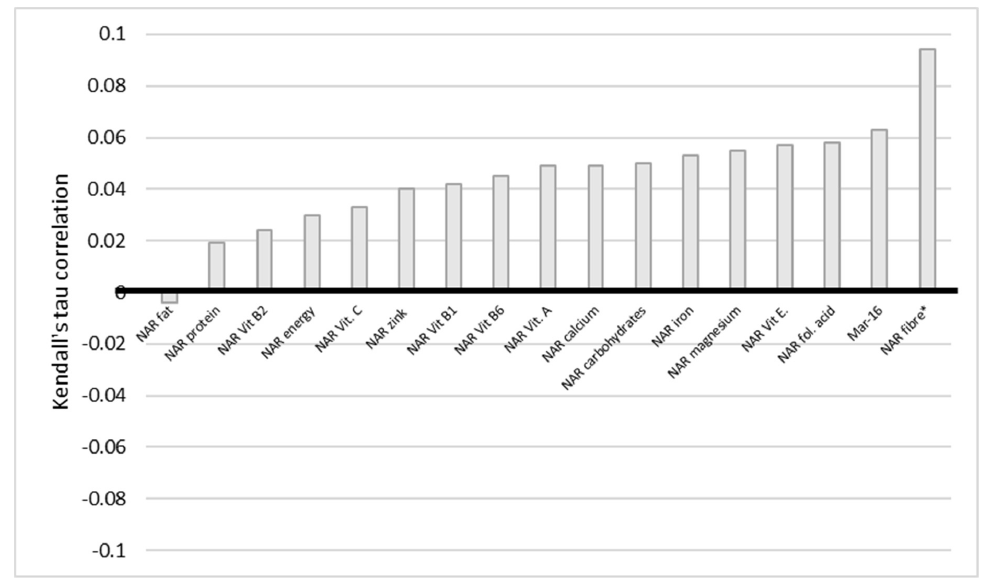
Figure 7 . Correlation of NAR for nutrients with BMI . BMI stands for body mass index. NAR— Figure 7. Correlation of NAR for nutrients with BMI. BMI stands for body mass index. NAR—nutrient nutrient adequacy ratio; Mar-16—mean nutrient adequacy for 16 nutrients; * p -value < 0.05. adequacy ratio; Mar-16—mean nutrient adequacy for 16 nutrients; * p -value <